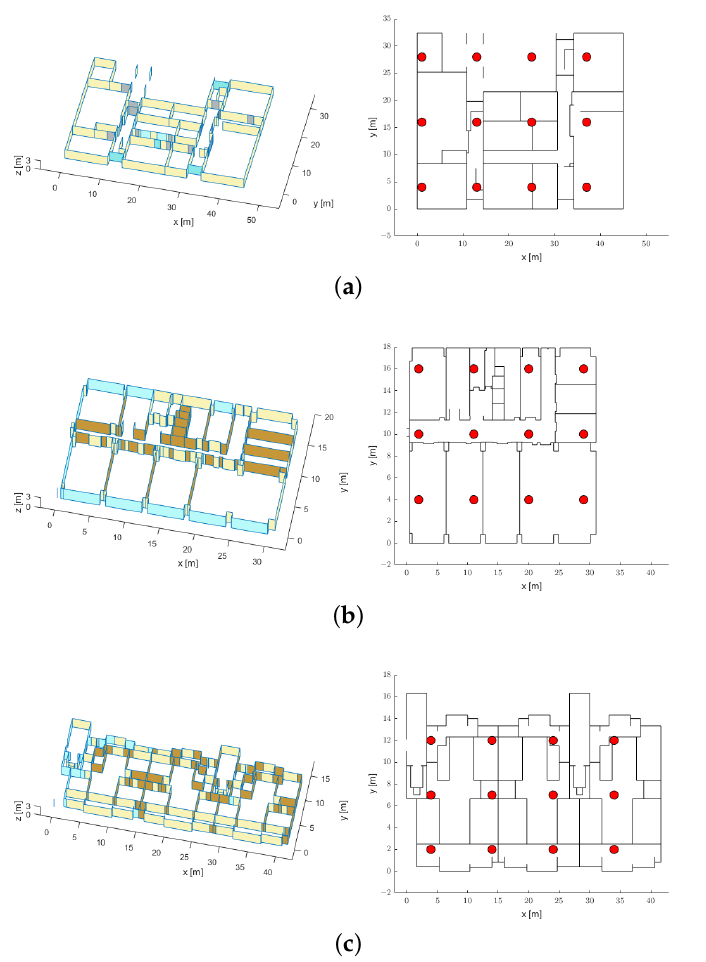
Figure 5. The 3D maps and the top views of the environments: ( a ) INMC (academic building), ( b ) ASRI (academic building), and ( c ) APT (residential